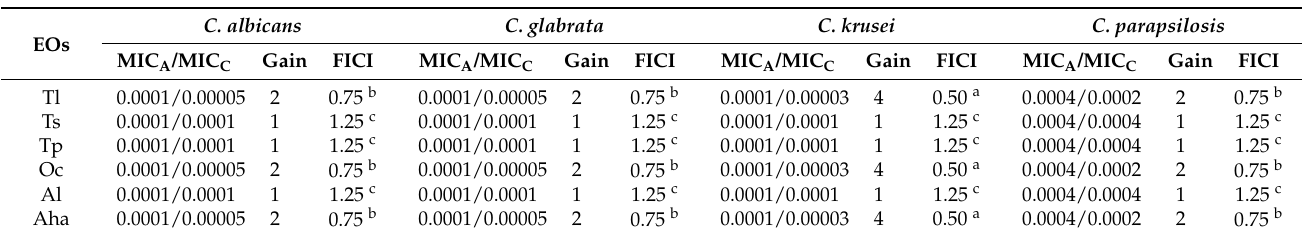
Table 5. Fractional inhibitory concentrations indices (FICIs) and gain of amphoterecin B combined with the essential oils.